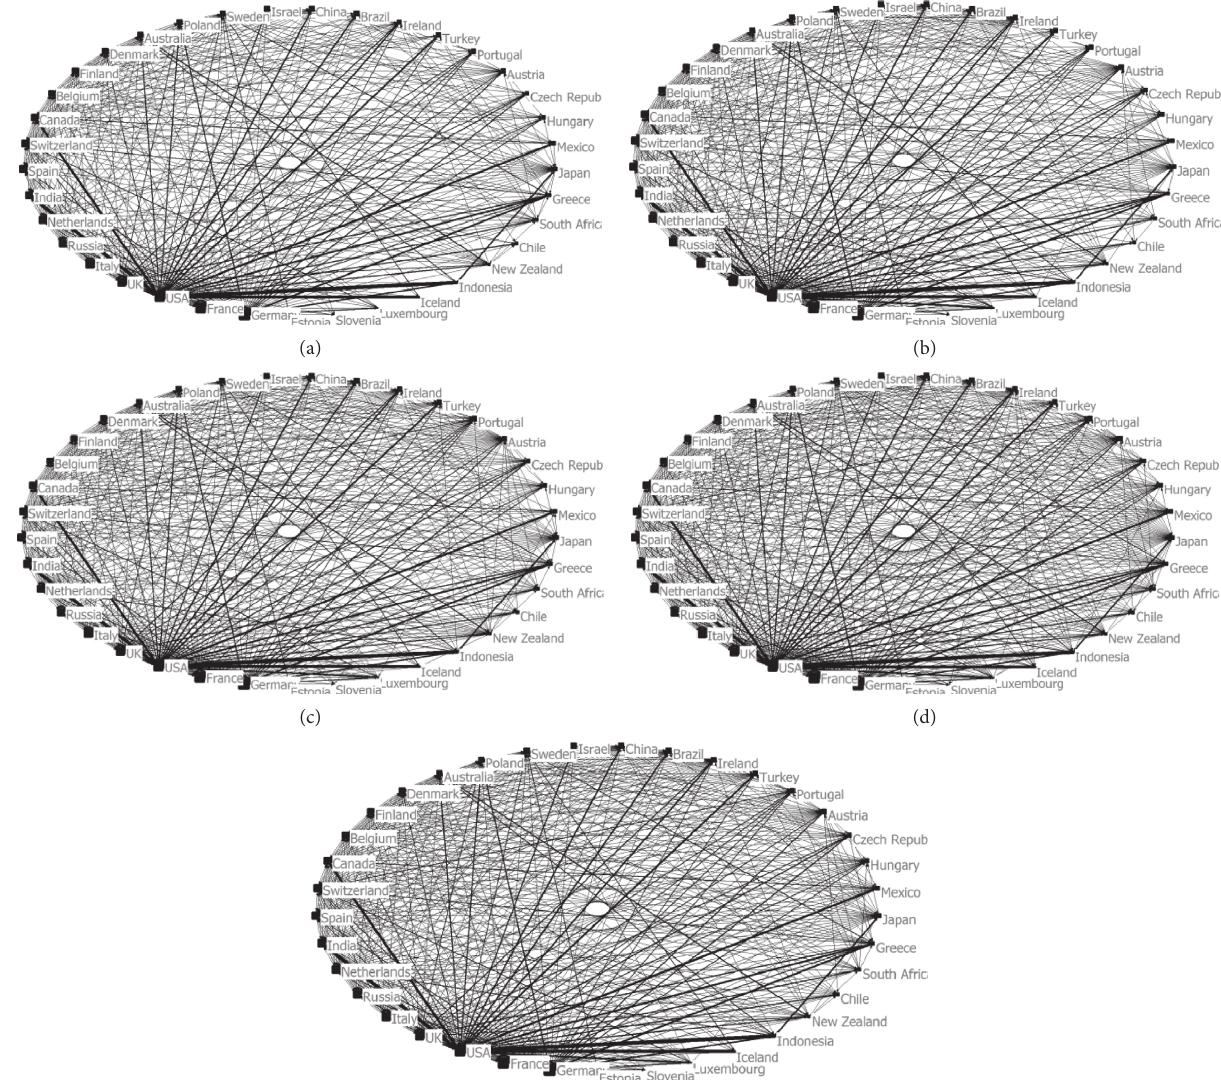
Figure 1: International migration network topologies of talents between the chosen countries in certain specific years. (a) The topology in 2001. (b) The topology in 2004. (c) The topology in 2007. (d) The topology in 2010. (e) The topology in